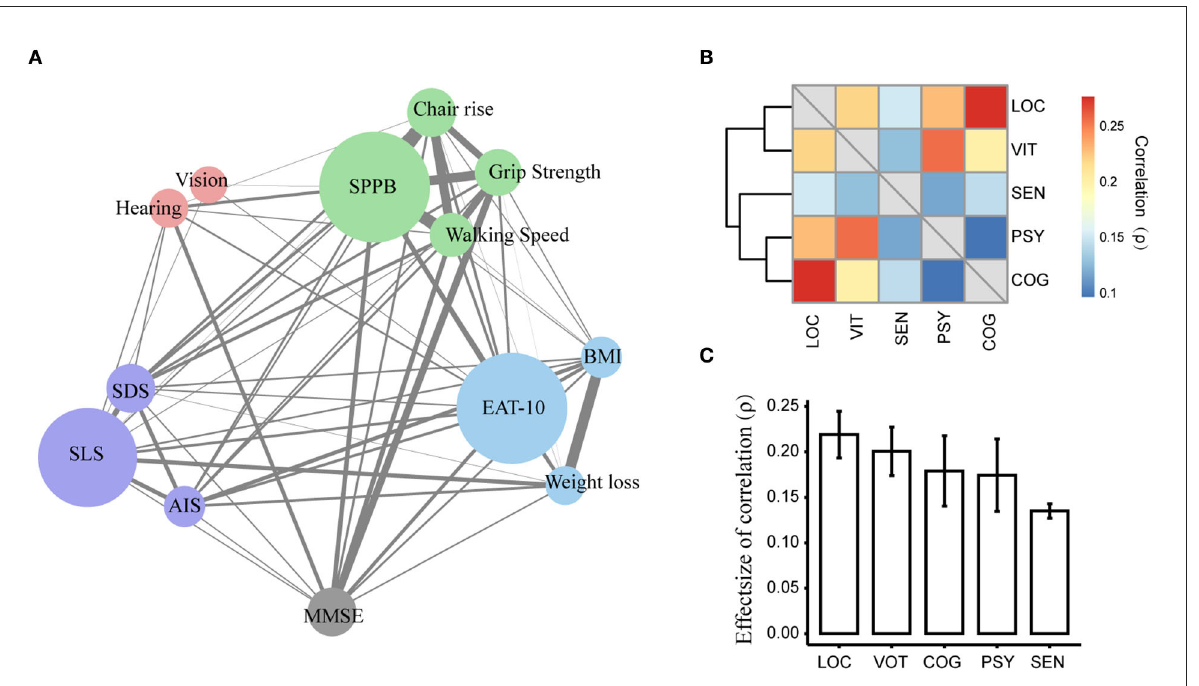
FIGURE3 Correlations between the measurement or domains of intrinsic capacity. (A) Correlations between measurements. The width of the edges represents the effect size of the correlation; the size of the nodes represents the centrality strength for measurements in the network. Only the significant correlation was plotted as a link; the width of the link represented the effect size of the correlation between the two measurements. (B) Correlation between IC domains. Heatmap shows the effect size of the correlations. (C) Mean correlation of one domain with others. MMSE, Mini-Mental State Examination; SPPB, Short Physical Performance Battery; AIS, Athens Insomnia Scale; SDS, self-reported depressive symptoms; SLS, self-report life satisfaction; Eat-10, 10 Items for Swallowing Assessment. LOC, locomotion domain; SEN, sensory domain; PSY, psychological domain; COG, cognition domain; VIT, vitality